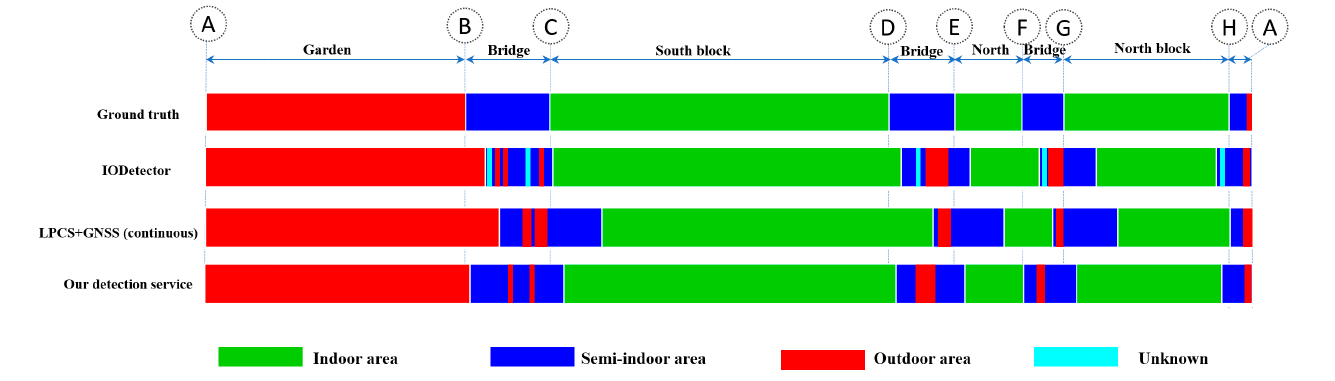
Figure 10. The switching responses of different I/O detection services. The positions of the transitions (A–H) are plotted in Figure 8.